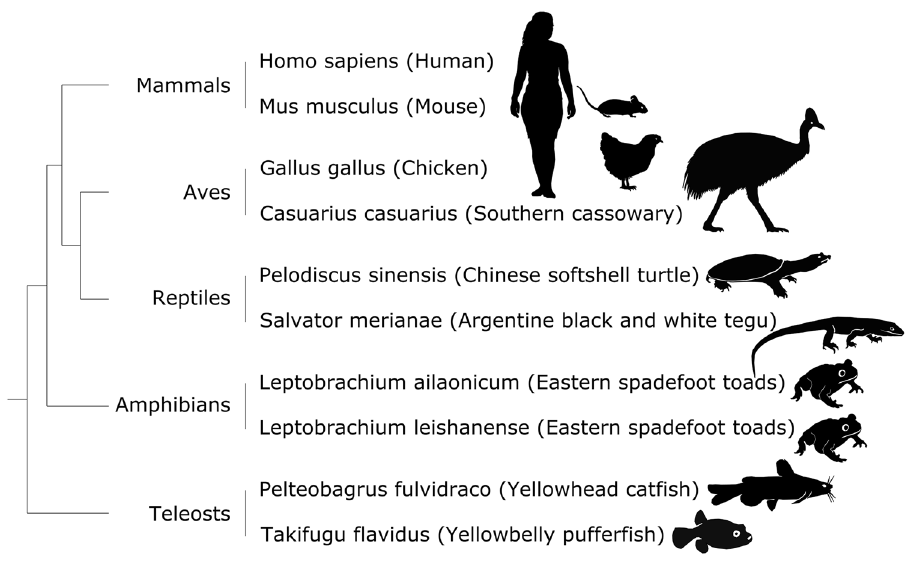
Figure 3. The phylogenetic tree of the species included in this